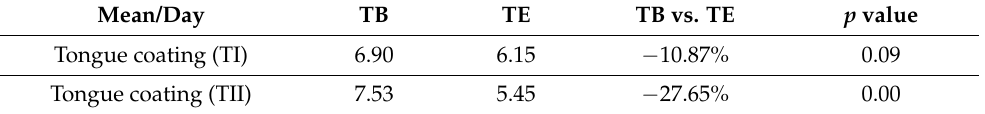
Table 3. The comparison of the tongue coating for the two Therapies I and